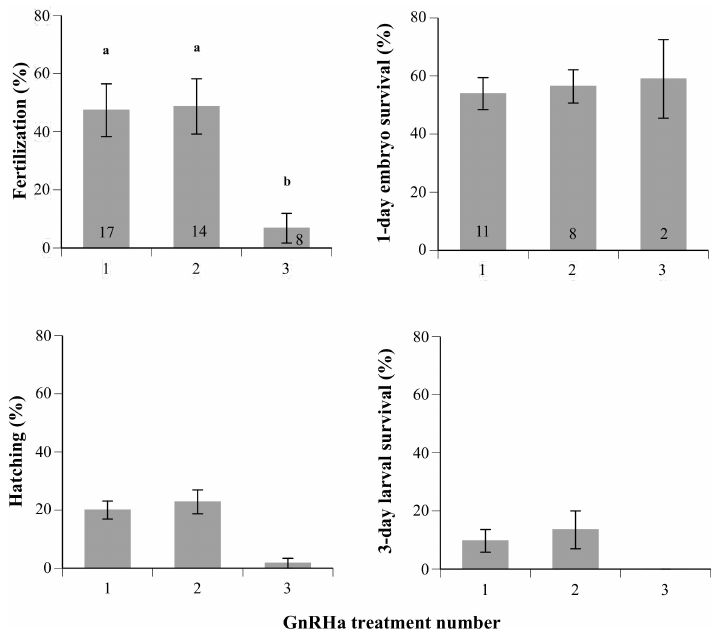
Figure 6. Mean ( ± SEM) egg quality parameters of F1 greater amberjack after three GnRHa implantations (May–July). Numbers in bars indicate the number of samples that constitute each mean. The number of samples of each mean for hatching (%) and three-day larval survival (%) are the same as for one-day embryo survival. Statistically significant differences among GnRHa implantations are indicated by different lower-case letters (a, b) ( p =